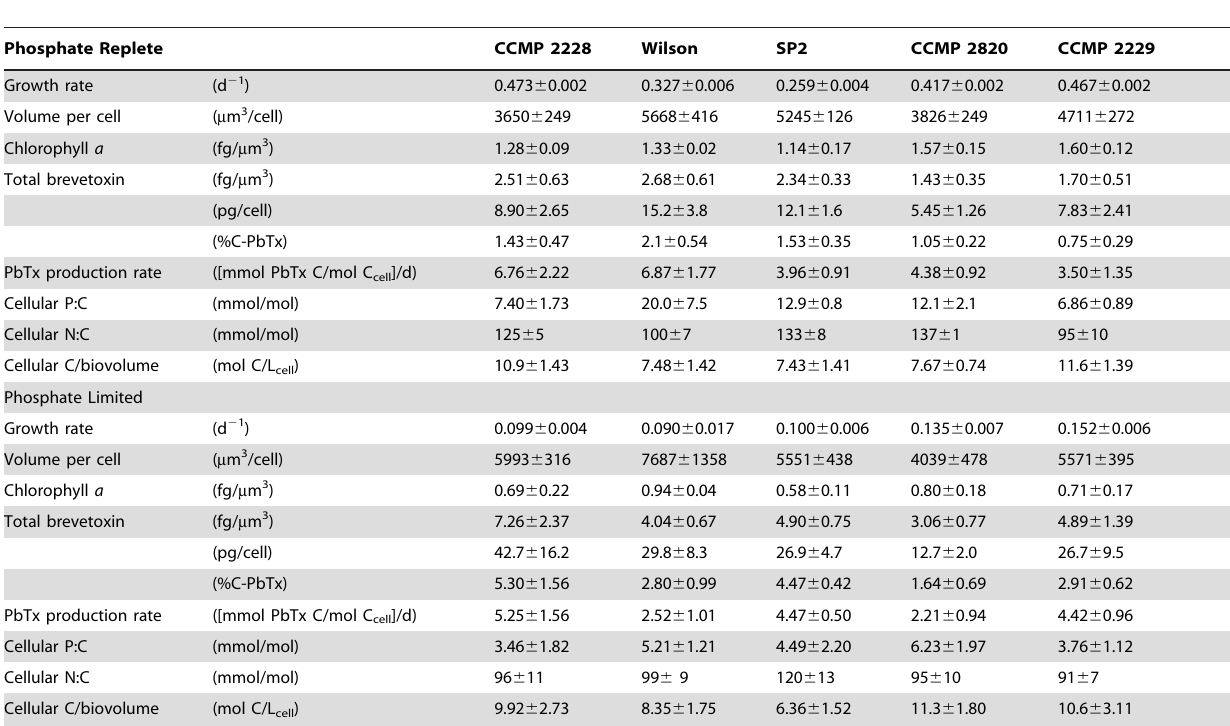
Table 3. Average values 6 standard deviations for growth rate (d 2 1 ), volume per cell ( m m 3 /cell), chlorophyll a (fg/ m m 3 ), total brevetoxins (fg/ m m 3 , pg/cell, and brevetoxin carbon as a percent of cellular C [%C-PbTx]), PbTx production rate ([mmol PbTx C/mol C cell ]/d), cellular P:C ratio (mmol/mol), cellular N:C ratio (mmol/mol) and cellular C normalized to biovolume (mol C/L cell ) for P- replete and P-limited experimental cultures of Karenia brevis